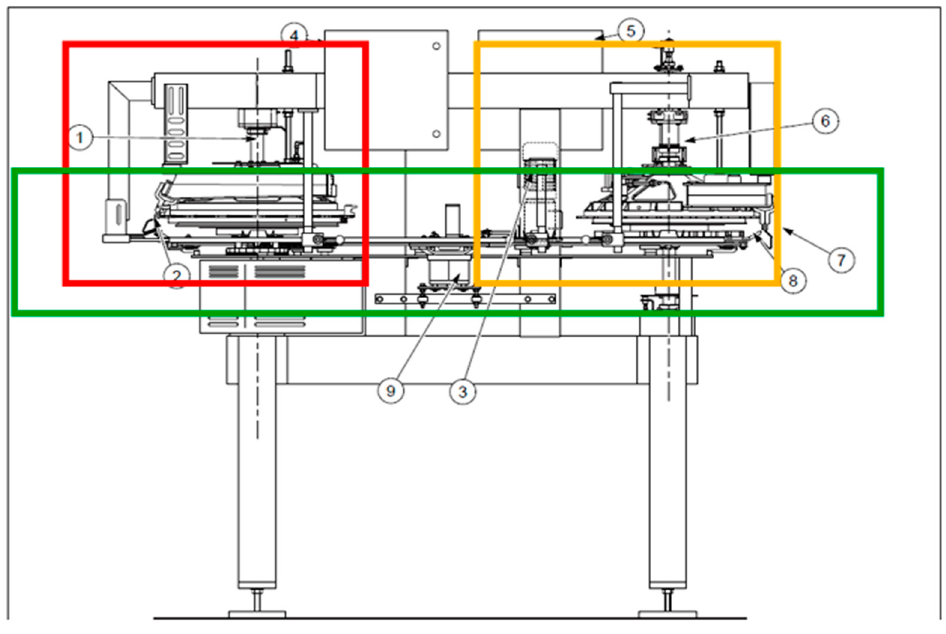
Figure 4. TR-CS functional unit.